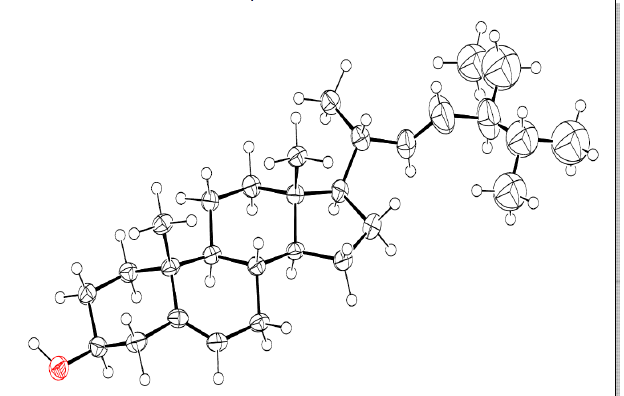
Figure 3. X-ray structure of compound 5